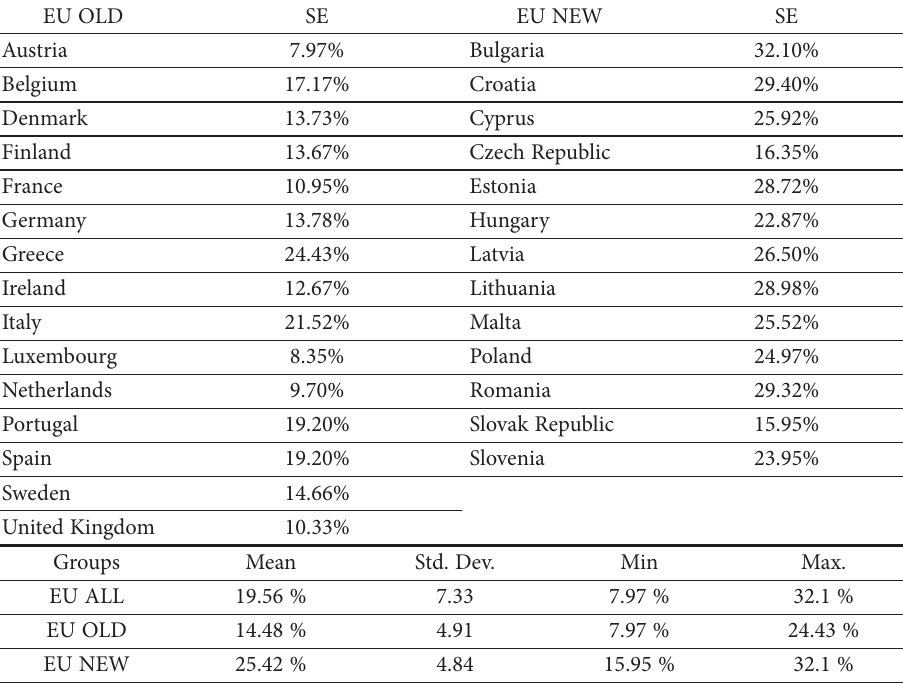
Table 2. The size of shadow economy (SE)-as percent in GDP, in EU countries (2008–2013 average) EU OLD SE EU NEW